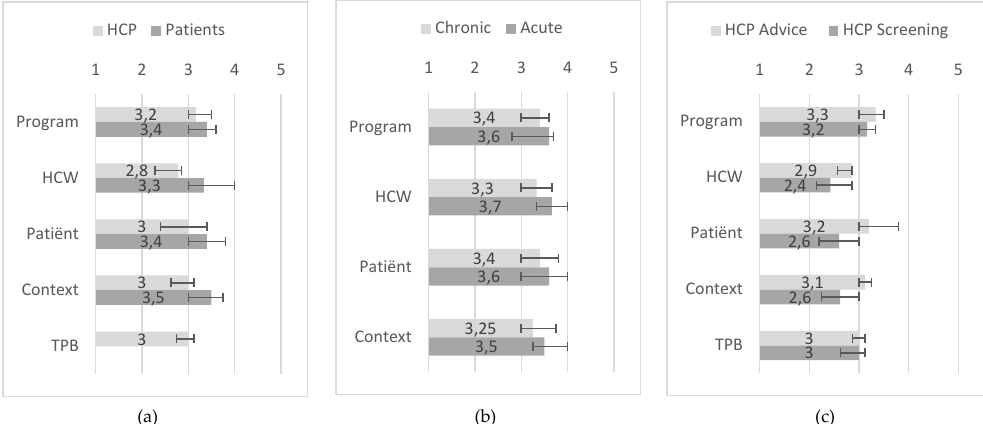
Figure 2 : Median and IQR of domains within patients and health care professionals: (a) Comparison of healthcare professionals and patients; (b) Comparison of chronic and acute care patients; (c) Comparison of healthcare professionals that were involved in the advice and that performed the screening. HCP=healthcare professional, GP=general practitioner, HCW=healthcare worker characteristic, TPB=Theory of planned behaviour characteristic